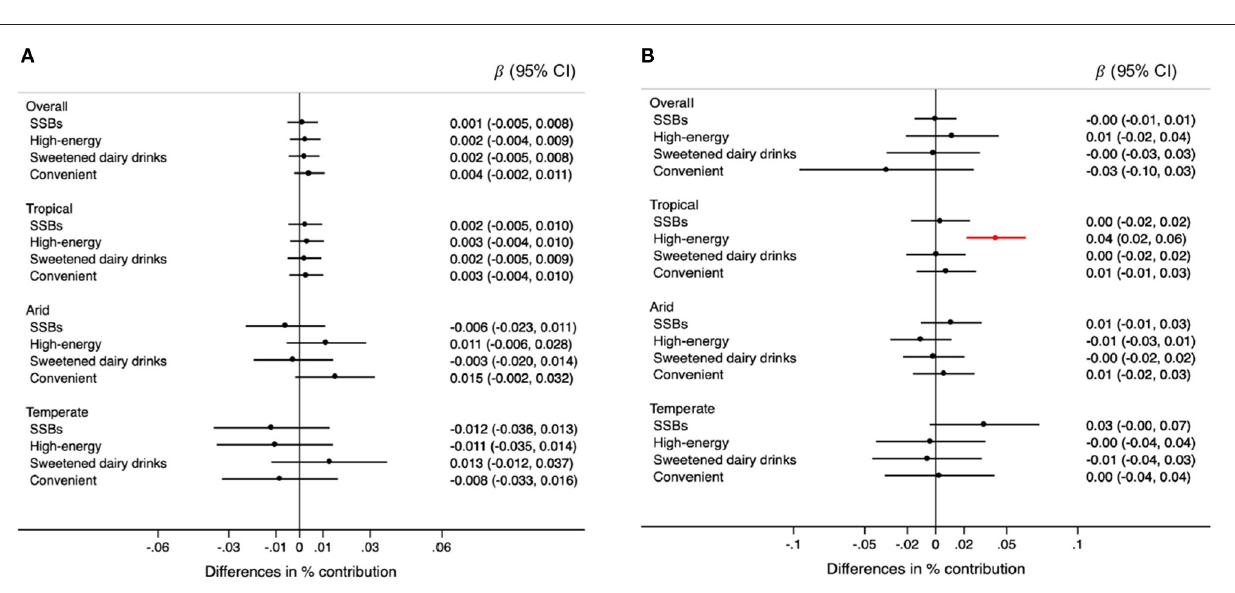
FIGURE 5 | Differences in the percentage (95% CIs) of contribution of types of ultra-processed foods and beverages to the total energy intake for each 0.5mm annual decrease in rainfall (A) and for each 0.1 ◦ C annual increase in temperature (B) during the 5-year period prior to the survey, overall and by climate region. Values were obtained using multivariable multilevel linear regression models adjusted for climate region (overall models) sex, age group, educational level, and rainfall or temperature, as appropriate. High-energy category includes candies, cookies, pastries, sweet bread, ready-to-eat cereals, and salty snacks. Convenient category includes processed meats, fast foods with processed meats, instant soups,